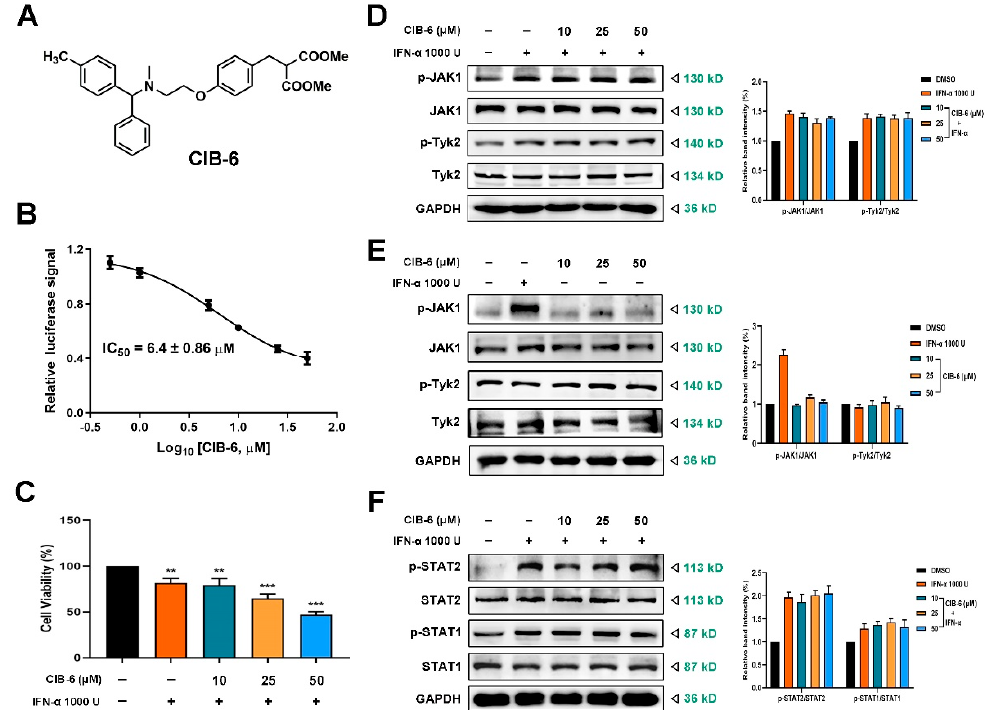
Figure 1. CIB-6 inhibits the interferon stimulated response element (ISRE) signal induced by interferon (IFN)- α without upstream kinase and signal transducer and activator of transcription 1 (STAT1)/STAT2 inhibition. ( A ) The chemical structure of CIB-6. ( B ) HepG2-ISRE-luc2 cells were seeded in 96-well plates, treated with different concentration of CIB-6 for 24 h, and administered 1000 U/mL IFN- α . The IC 50 value of CIB-6 was calculated. Results are representative of three experiments. ( C ) HepG2 cells were treated with the indicated concentrations of CIB-6 and IFN- α for 24 h. The data are presented as mean ± SD of three independent experiments. (** p < 0.01 and *** p < 0.001 as compared with DMSO). The SK-HEP-1 cells were treated with the indicated concentrations of CIB-6 for 24 h. ( D , E ) The cell lysates were immunoblotted with antibodies against phosphorylated and total proteins of Janus kinase 1 (JAK1) and Tyk2 with or without 1000 U/mL IFN- α stimulation. ( F ) The cell lysates were immunoblotted with antibodies against phosphorylated and total proteins of STAT1 and STAT2.